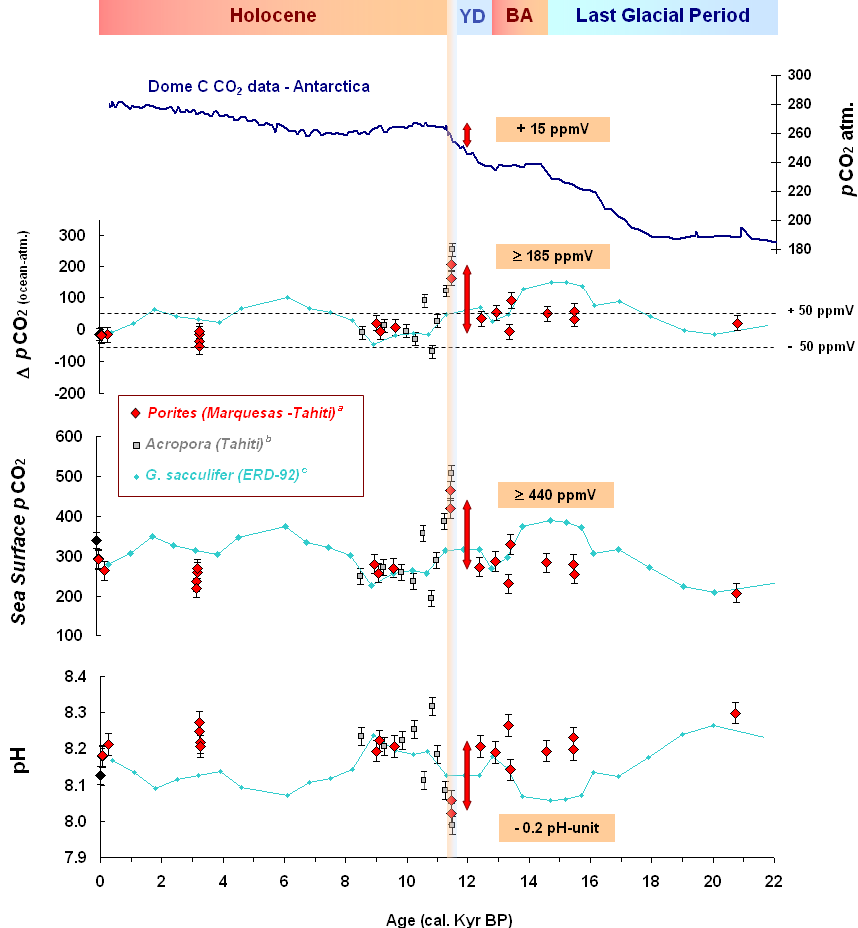
Fig. 7. Comparison of the sub-Equatorial Pacific δ 11 B-pH of marine biogenic carbonates over the last 21000calyr. Sources are (a) this study; (b) Gaillardet and All`egre, 1995; and (c) Palmer and Pearson, 2003. Filled black diamond: modern Moorea-Tahiti Porites value published by Gaillardet and All`egre (1995). The calculation parameters for the pH are α =0.981; δ 11 B SW =39.9‰; S =35‰; and T =27 ◦ C for Tahiti (Moorea) and T =28 ◦ C for the Marquesas Islands and for ERDC-92. Deduced 1p CO 2 values (Table 1, see text) and atmospheric p CO 2 data (Monnin et al., 2001, 2004) are also plotted to illustrate the synchronization between the abrupt changes to the sea surface pH and 1p CO 2 in the central sub-Equatorial Pacific and the atmospheric CO 2 increase of 15–20ppmV at the end of the YD